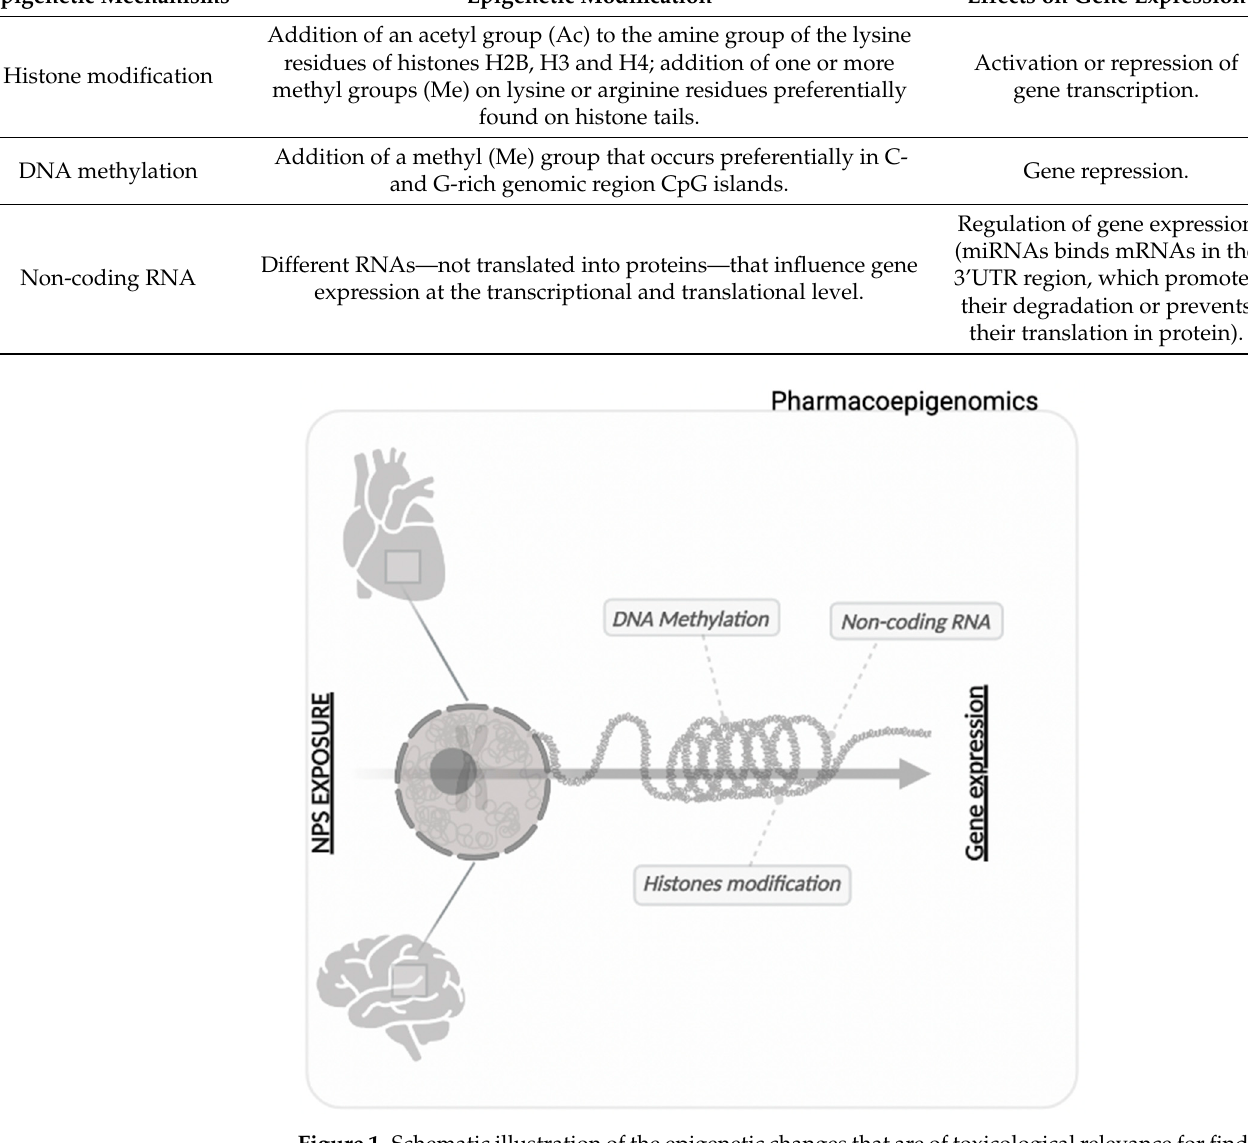
Figure 1. Schematic illustration of the epigenetic changes that are of toxicological relevance for finding useful markers in a context of predicting cardiac and brain damage. Exposure to an NPS induces changes in the epigenetic landscape that could provide the basis for a panel of pharmacoepigenetic markers to predict toxicological damage to vital organs. The study of gene expression variations in a pharmacoepigenomic context is indicative of the variability between individuals in their responses to drugs or drugs of abuse.